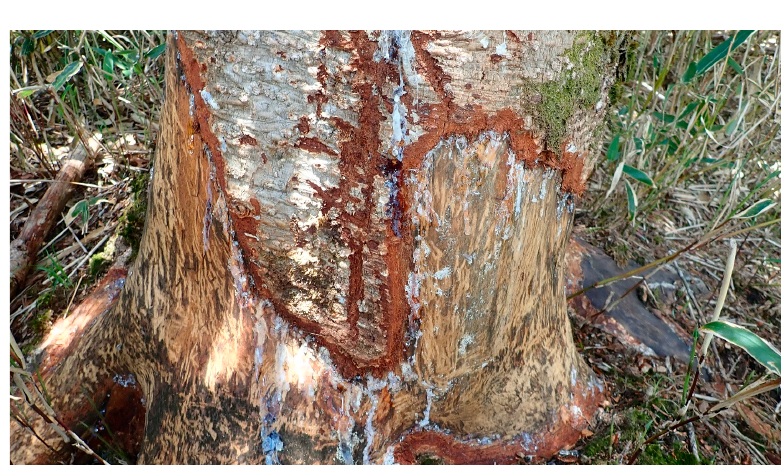
Figure 2. A. homolepis with bark stripping at the root